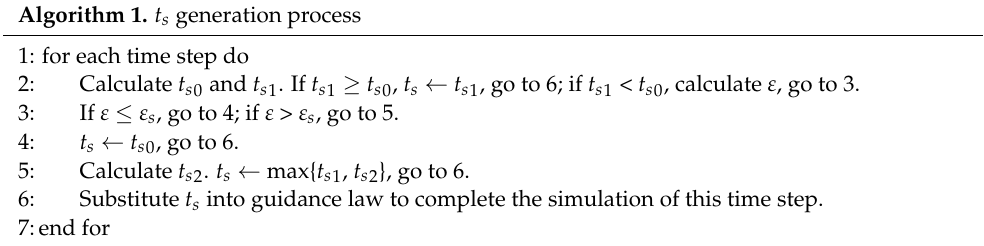
Algorithm 1. t s generation